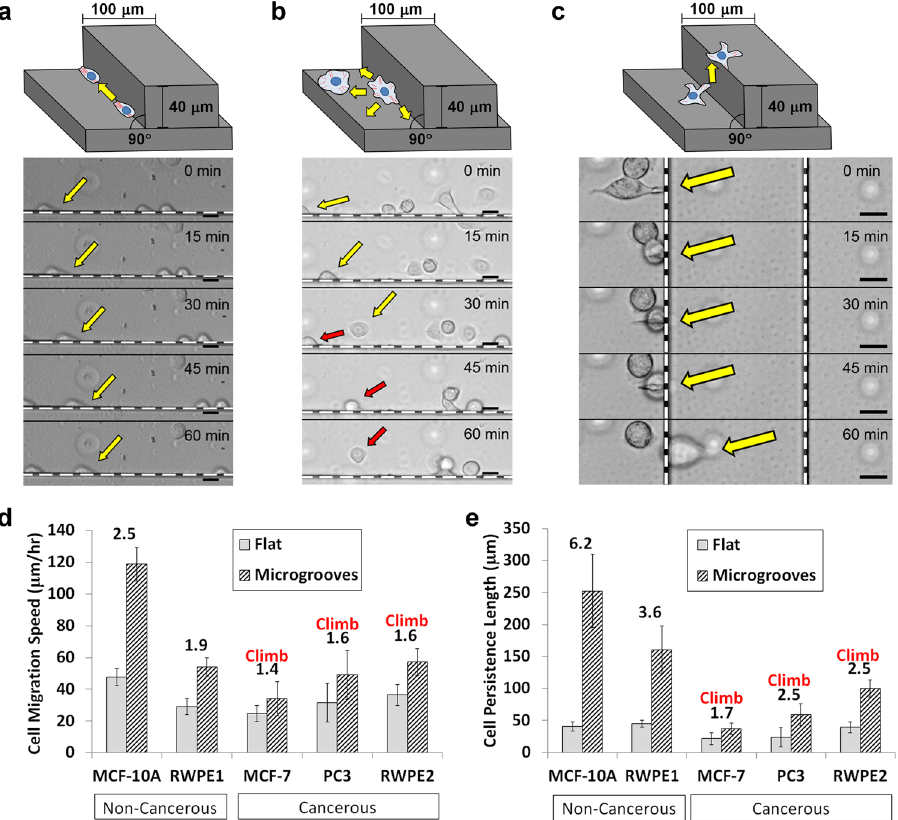
Figure 1. Schematic illustrations of the different modes of cell migration on the PDMS microgroove structures and time-lapse images of ( a ) RWPE1 (non-cancerous; persistent) and ( b ) RWPE2 (cancerous; non-persistent) cell migration along the groove walls (the dotted white lines in each image), as well as ( c ) PC3 (cancerous) cell climbing over the walls. Colored arrows point to notable cells in each image. (Scale bar, 20 μ m) ( d ) Speed and ( e ) persistence length measurements of various non-cancerous and cancerous epithelial cell types on the flat surfaces and at the corners of the microgrooves. Numbers above the bars represent the quantitative effect of topography as the ratio between the groove and flat measurements. “Climb” signifies that the cell type could climb over 40- µ m-high walls. Error bars are SEM (N = 5 trials with 10–20 cells quantified per